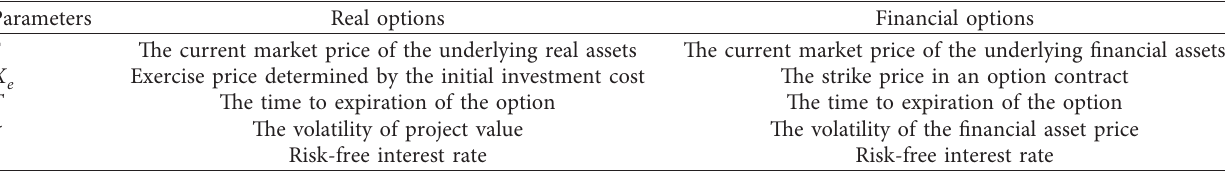
Table 1: Variables between real and financial options in the B-S